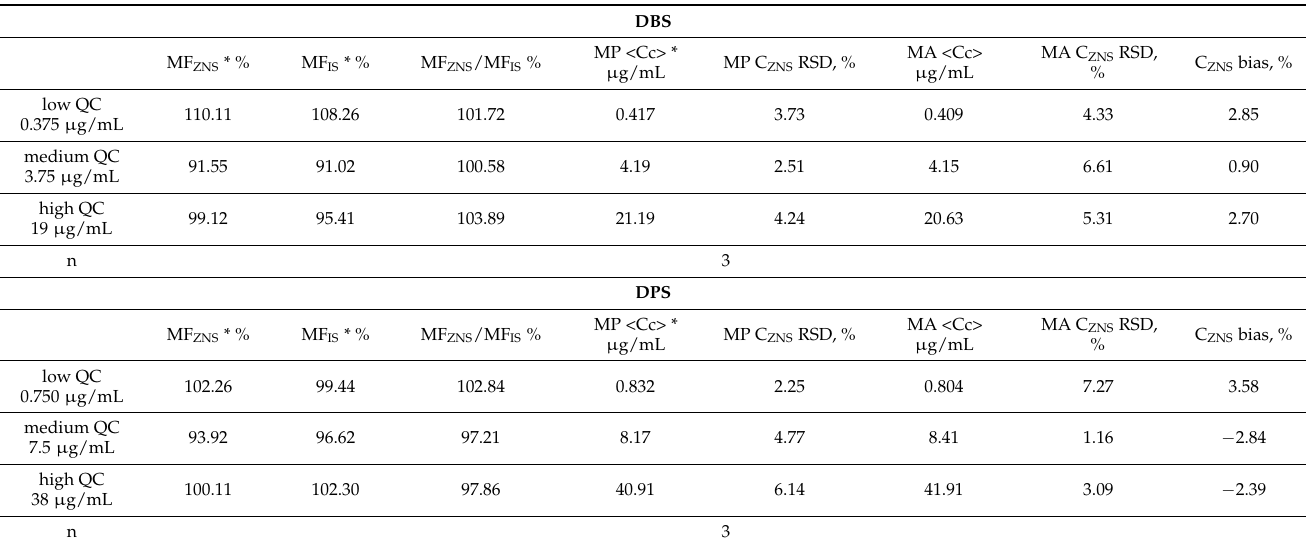
Table 4. Matrix effect estimated via matrix factors of ZNS and IS and IS normalized matrix factor.